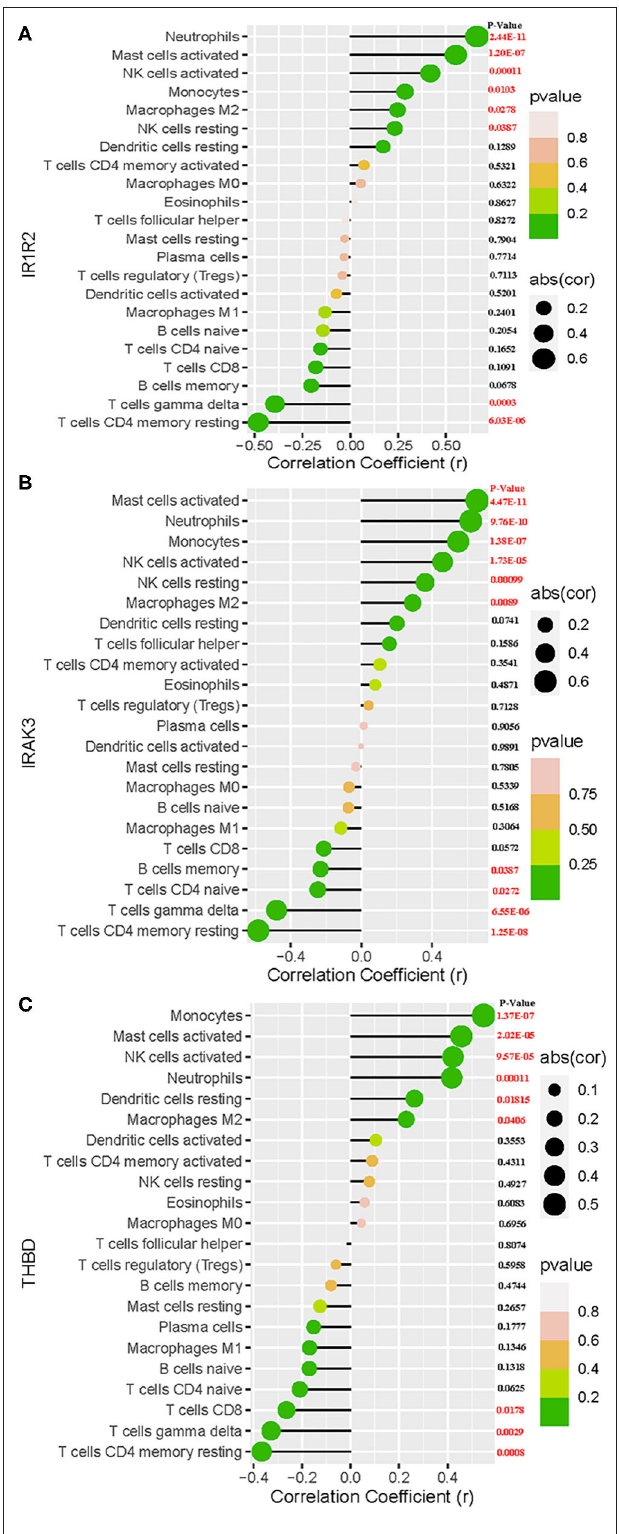
FIGURE 7 | Correlation between IL1R2 (A) , IRAK3 (B) , THBD (C) , and infiltrating immune cells in acute myocardial